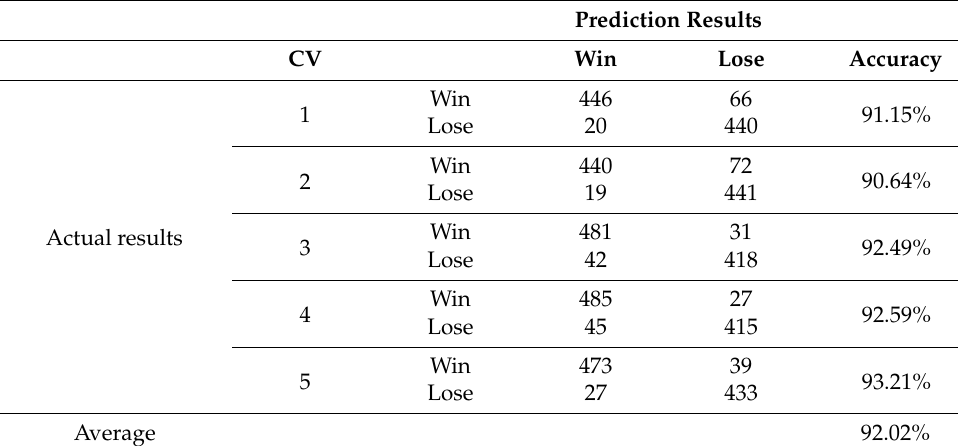
Table 7. Confusion matrix of ANN without feature selection (dataset 1).